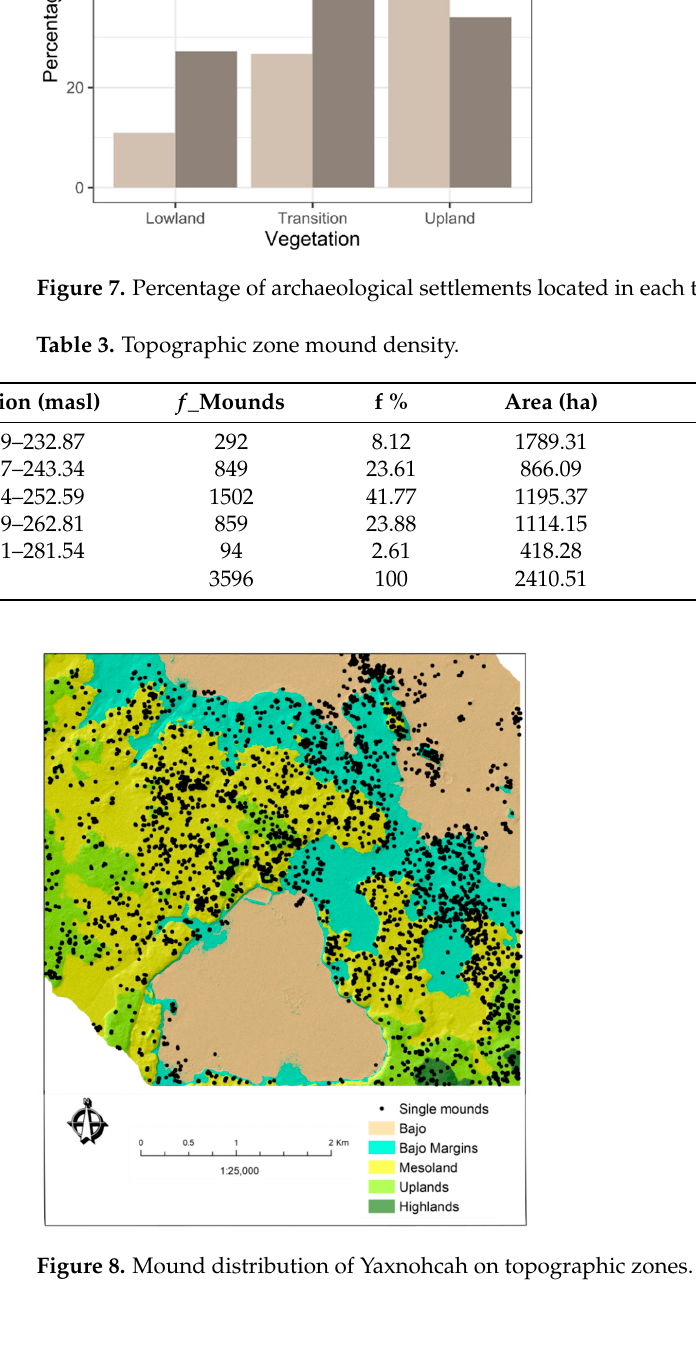
Figure 8. Mound distribution of Yaxnohcah on topographic zones.